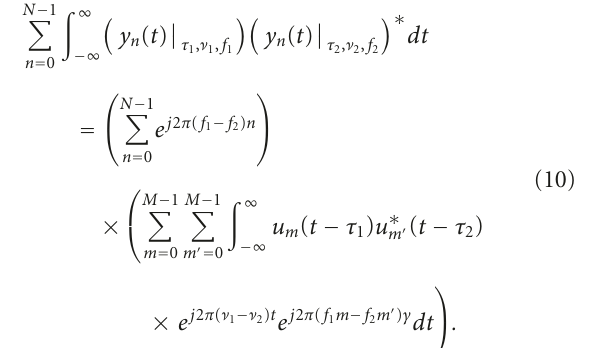
in Figure 2, each transmitter waveform u m ( t ) consists of a stream of L identical pulses φ m ( t ). Each pulse in turn contains Q constant amplitude frequency subpulses each having width Δ t and frequency c m , q Δ f . Here we only concern ourselves with waveforms that are orthogonal at